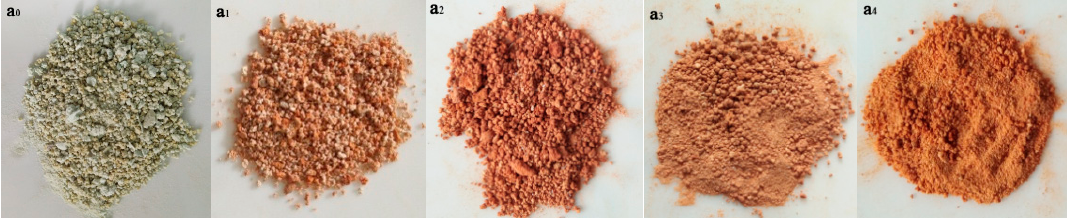
Figure 10. Morphology of MOF ( a 0 , a 1 , a 2 , a 3 , a 4 ) at different degradation times in the wheat farm soil.